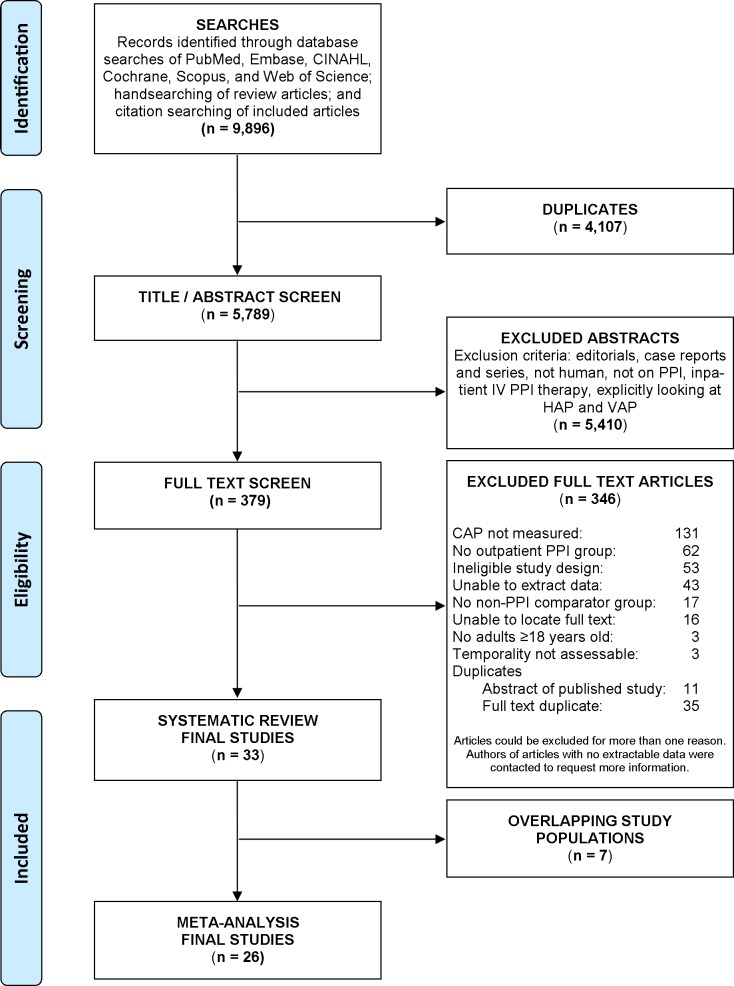
Flow Diagram of Study Selection, adapted from PRISMA Group 2009 Flow Diagram.Studies could be excluded for more than one reason, therefore the sum of exclusion reasons exceeds total studies. Examples of studies lacking extractable data included abstracts without full results (such as abstracts reporting an odds ratio without exposure or outcome definitions) or papers summarizing outcomes qualitatively in the text (such as manuscripts reporting adverse event categories that grouped pneumonia among other events).